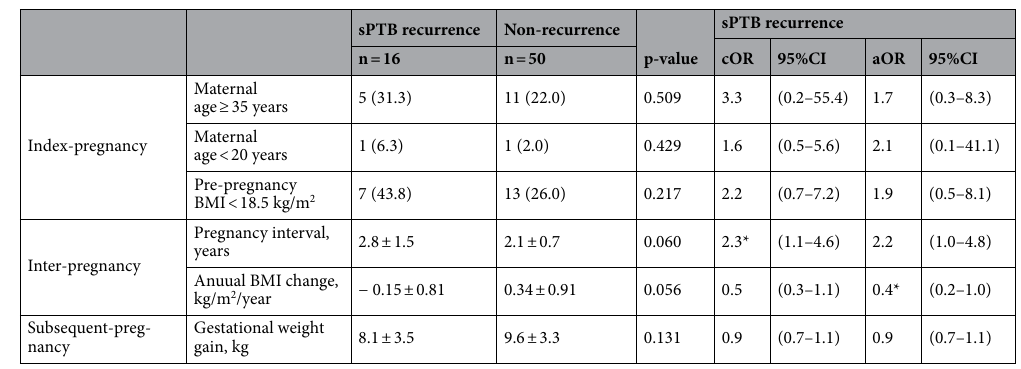
Table 3. Univariable and multivariable logistic regression analysis of variables potentially associated with sPTB recurrence (n = 66). cOR, clude odds ratio; aOR, adjusted OR; CI, confidence interval; BMI, body mass index; sPTB, spontaneous preterm birth. *Statistically